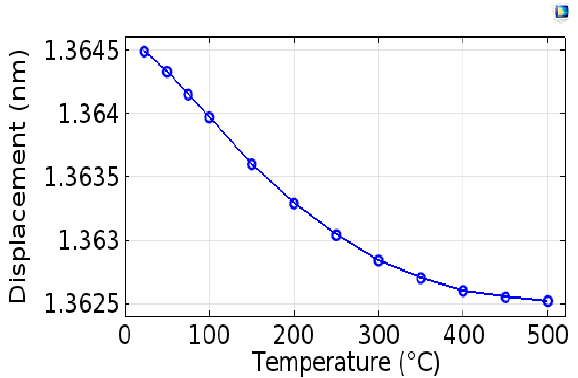
Figure 10. Evolution of mechanical displacements as a function of the temperature obtained by simulation.